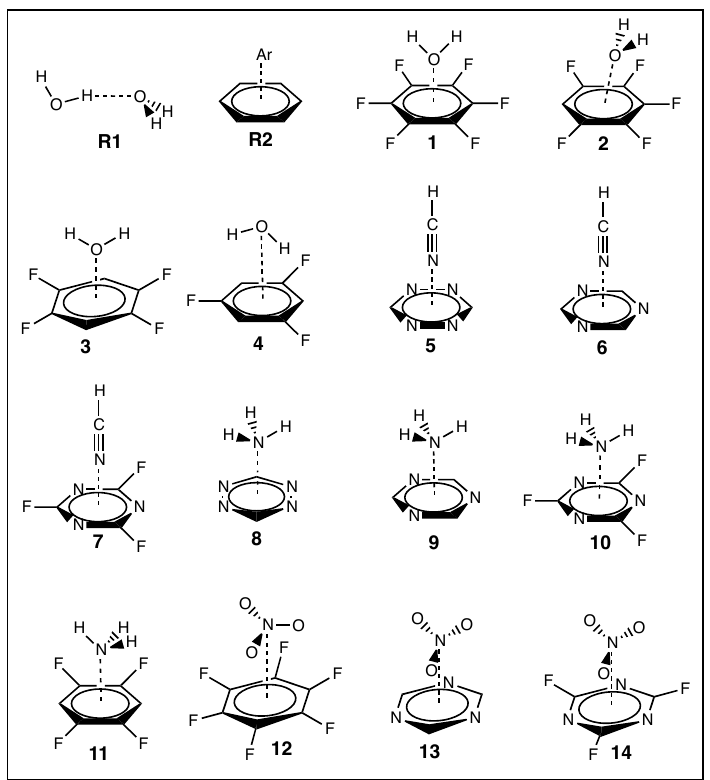
Figure 1. Schematic of the two references systems, R1 and R2 , and π –hole systems 1–14 studied in this work showing molecular geometries of each system; calculated at the ω B97X–D/aug–cc–pVTZ level of